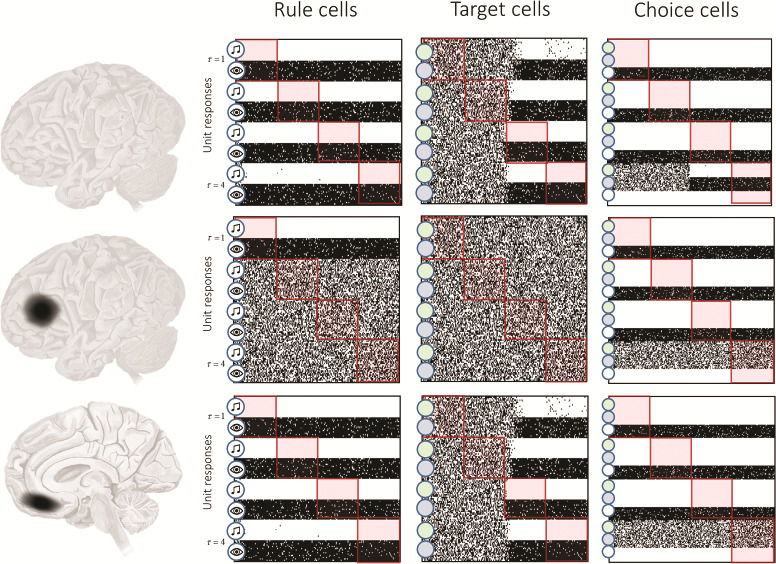
Synthetic prefrontal lesions. In the upper row of this figure, we reproduce the simulated raster plots from Figure 5. In the middle and lower row, we show raster plots of the same cells during the same trials (brown noise, followed by an auditory cue to the blue target), but with lesions to the lateral or medial prefrontal cortex. Lesions to the lateral cortex (middle row) were simulated by using uniform distributions for the transition probabilities associated with the rule hidden state. This effectively disconnects the \documentclass[12pt]{minimal}
\usepackage{amsmath}
\usepackage{wasysym}
\usepackage{amsfonts}
\usepackage{amssymb}
\usepackage{amsbsy}
\usepackage{upgreek}
\usepackage{mathrsfs}
\setlength{\oddsidemargin}{-69pt}
\begin{document}
}{}$\mathbf{B}$\end{document}-connections (Fig. 3) for this cell population. Medial lesions (lower row) were simulated by setting the \documentclass[12pt]{minimal}
\usepackage{amsmath}
\usepackage{wasysym}
\usepackage{amsfonts}
\usepackage{amssymb}
\usepackage{amsbsy}
\usepackage{upgreek}
\usepackage{mathrsfs}
\setlength{\oddsidemargin}{-69pt}
\begin{document}
}{}$\mathbf{A}$\end{document}-connections from the feedback outcomes to uniform distributions. This disconnects interoceptive regions from the medial prefrontal cortex.